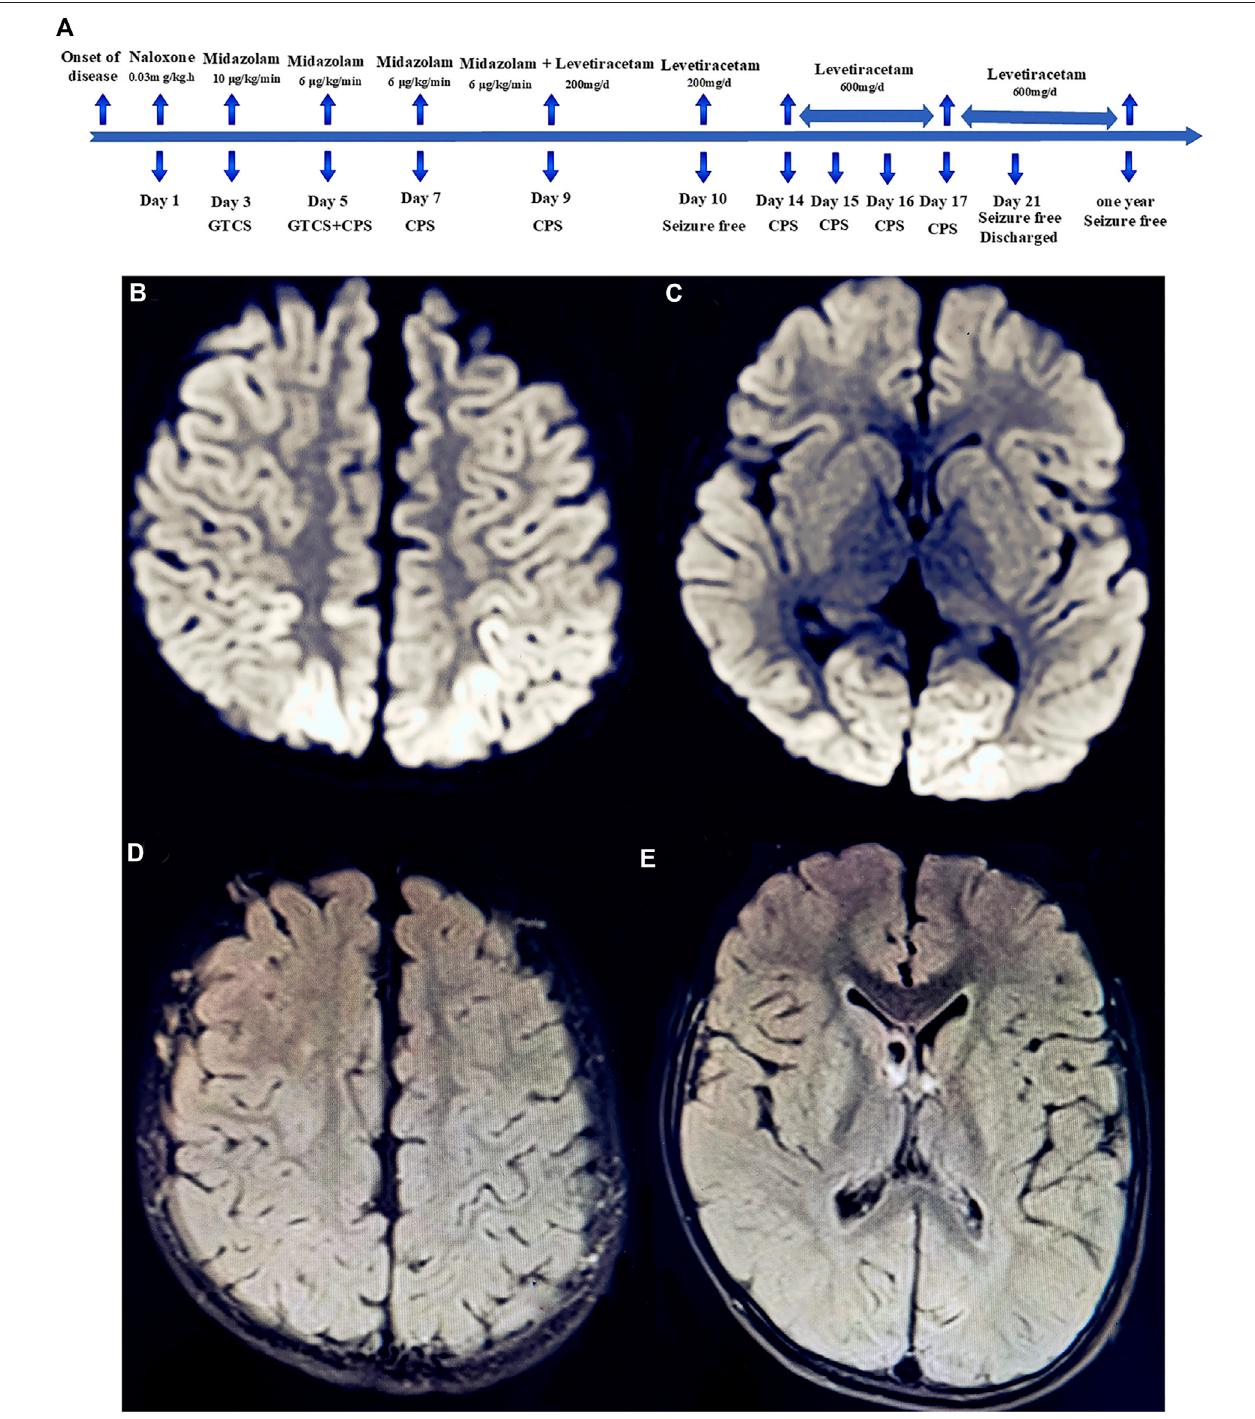
FIGURE 2 | Timeline of the patient ’ s clinical course and outcome (A) . Diffusion-weighted magnetic resonance imaging (DW-MRI) of the head showed abnormal high signal intensity in the bilateral parietal lobe (B) , anterior wedge, and occipital lobe (C) . Head MRI-DWI re-examined after 1 year of follow-up revealed that the abnormal signal intensity of brain gray matter disappeared completely (D,E) .